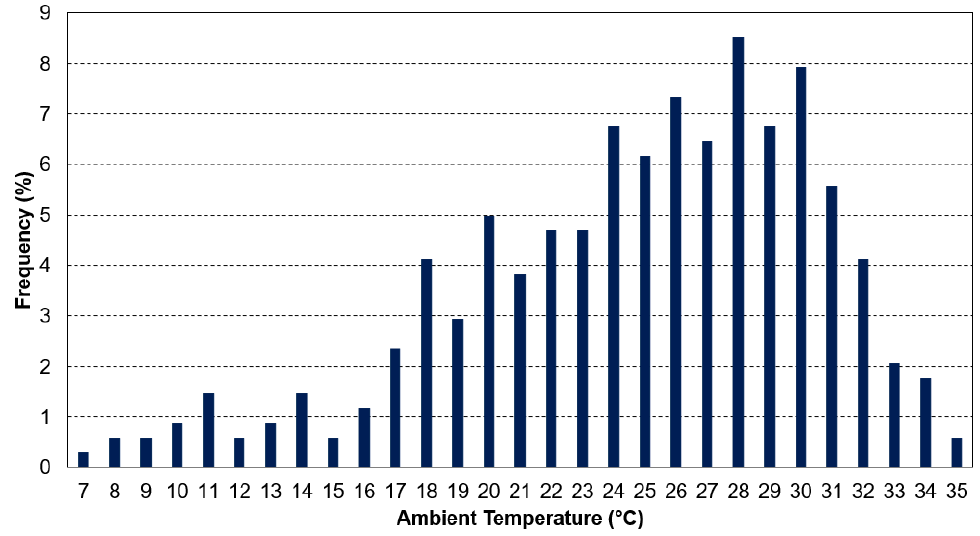
Figure 5. Ambient temperature